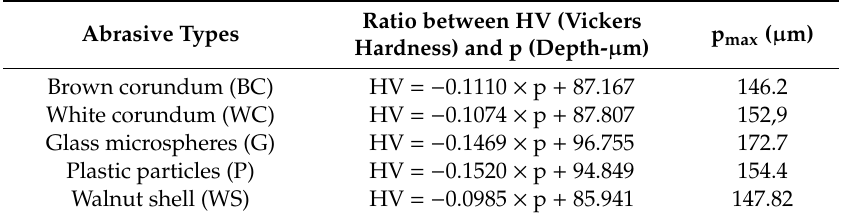
Table 4. Ratio of Vickers hardness (HV) to indentation depth p ( µ m) on EN AW-5182 substrates after blasting with various abrasives from 0.4 to 0.6 MPa for PTFE